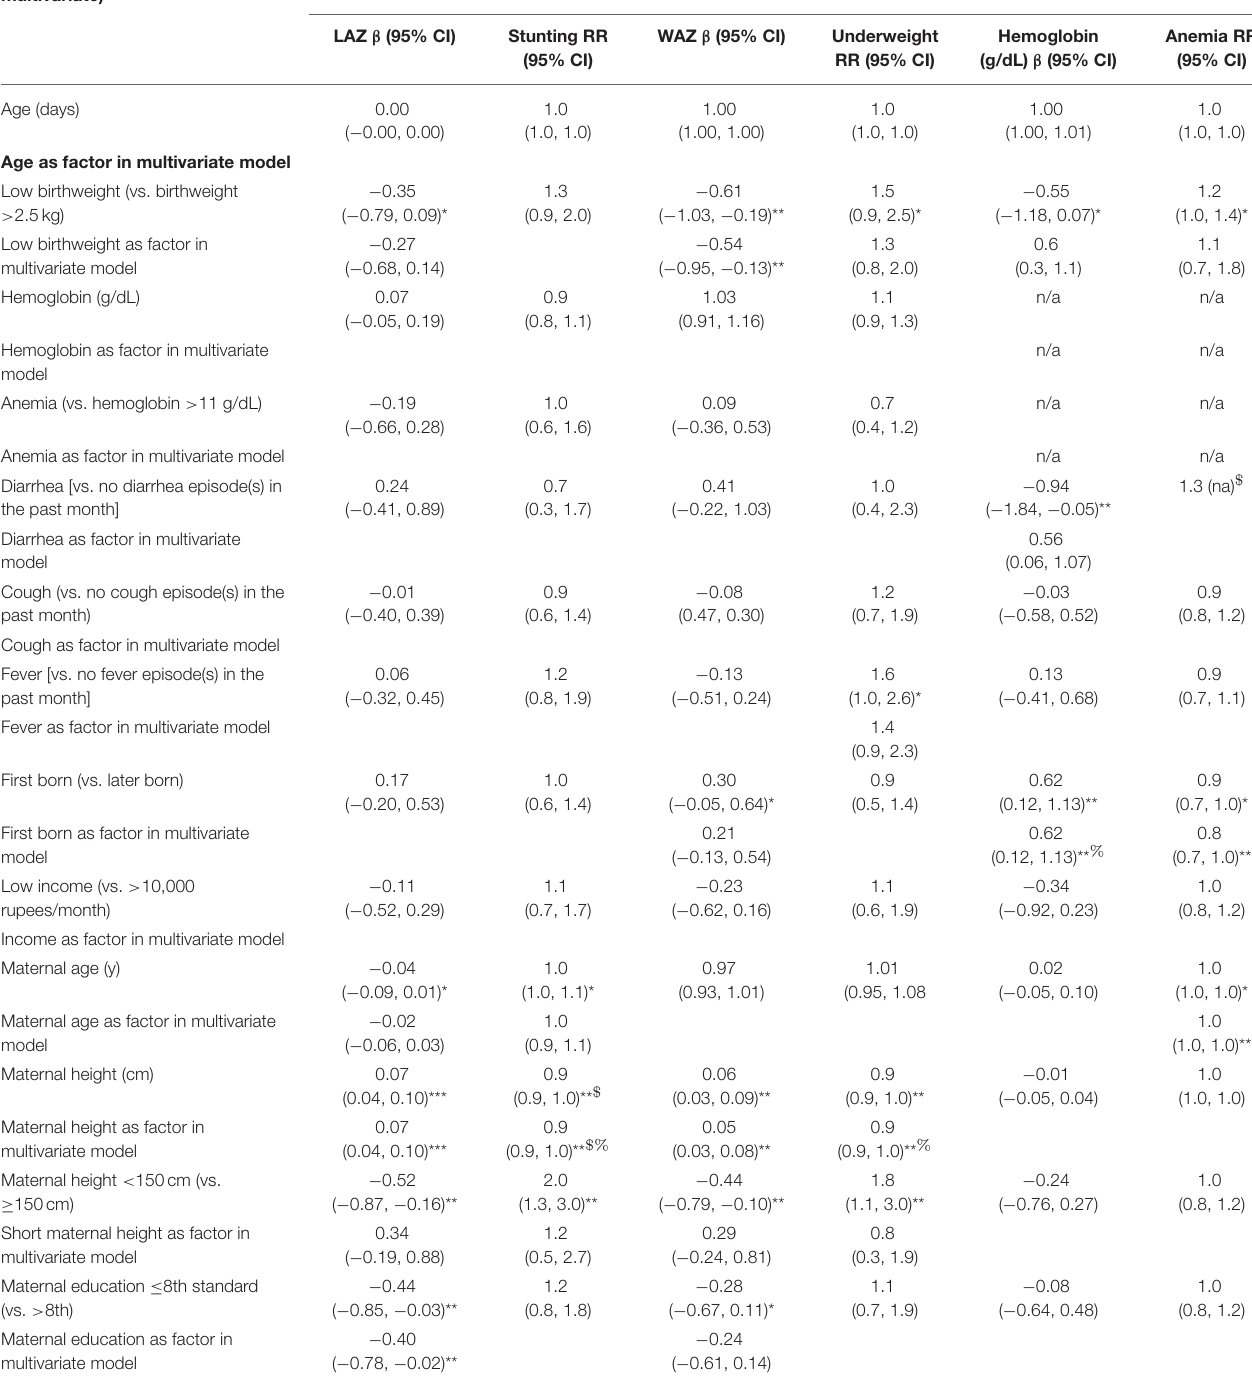
TABLE 3 | Correlates of poor growth and anemia among n = 164 male children. Correlate (univariate,